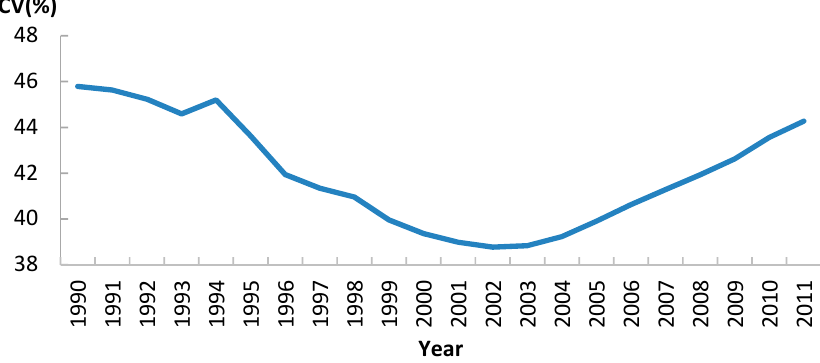
Figure 7. The trend of Coefficient of Variation for U5MR in Africa, 1990–2011.